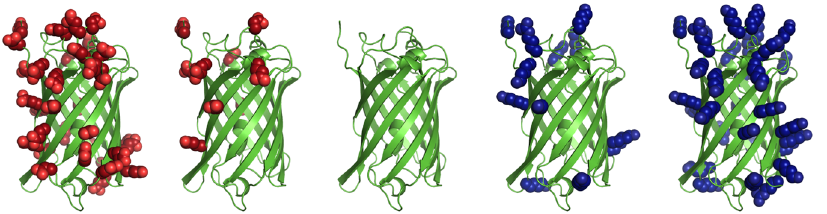
Figure 1 . Illustration of supercharged GFP surfaces. The GFP backbone is shown in green cartoon, Asp/Glu side chains are shown in red spheres, Arg/Lys side chains are shown in blue spheres. Left : mutations in negatively-supercharged variants. Center : wild-type superfolding GFP. Right : mutations in positively-supercharged variants.